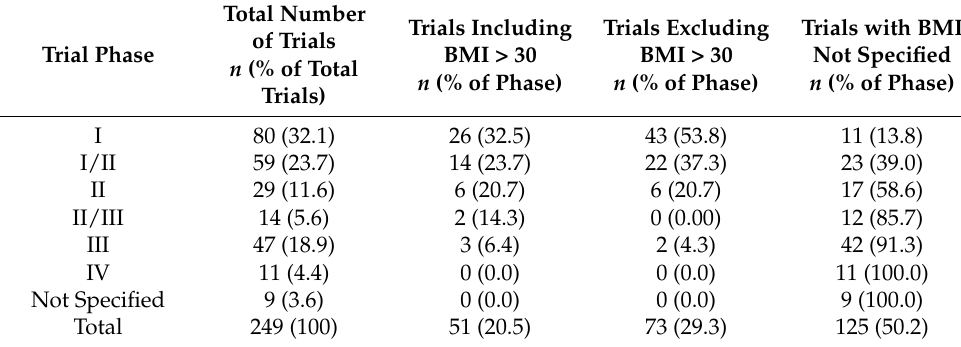
Table 3. BMI > 30 participation in COVID-19 vaccine trials by trial